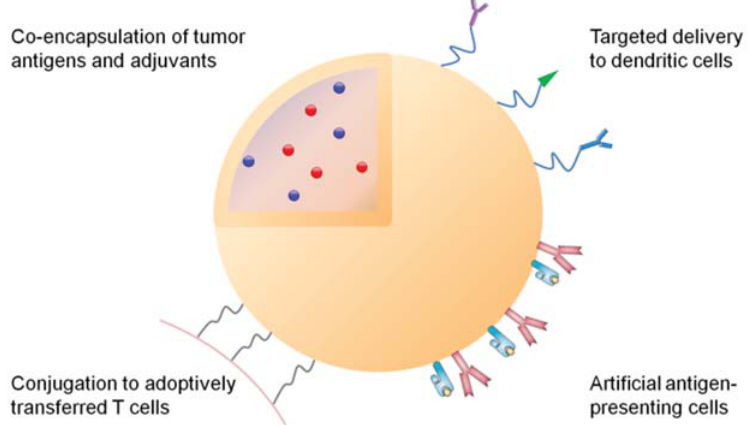
Figure 1. Multi-functional nanoparticles for cancer immunotherapy. Tumor antigens